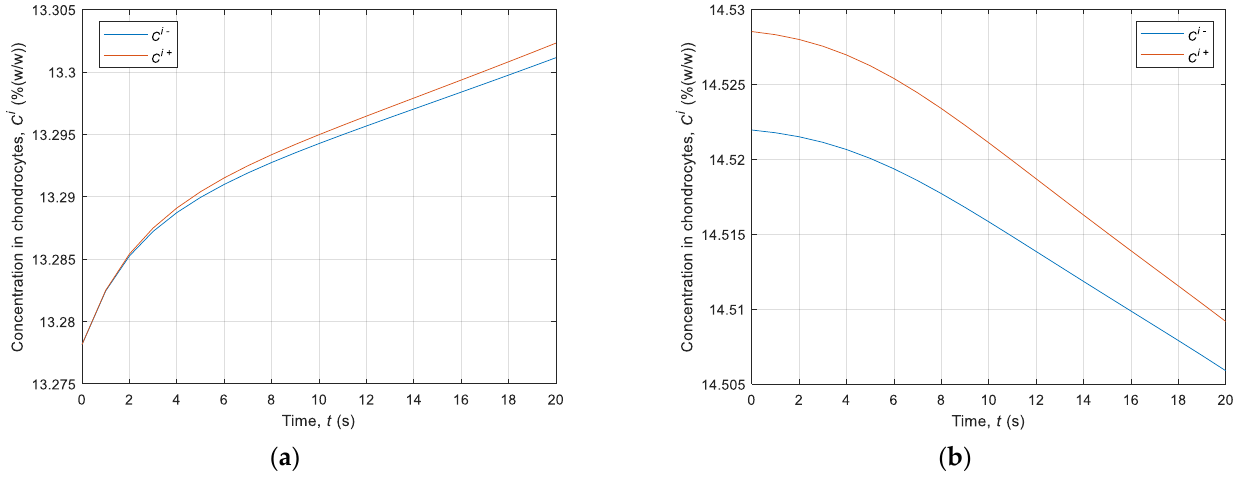
Figure 4. History of the intracellular concentration over time: ( a ) from 22 ◦ C to − 5 ◦ C; ( b ) from − 5 ◦ C to 22 ◦ C.